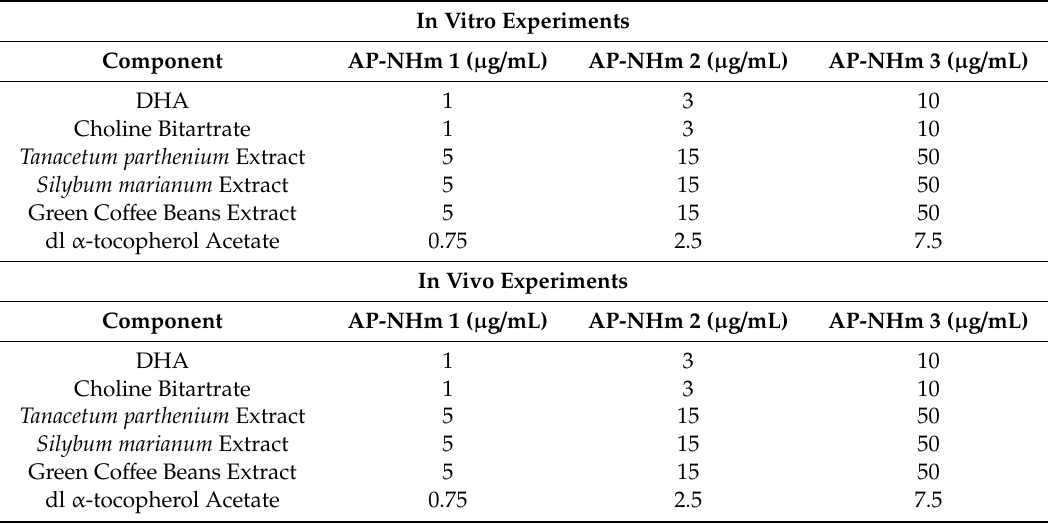
Table 1. Concentration of components in multicomponent food supplement mixtures (AP-NHm): each preparation for in vitro and in vivo